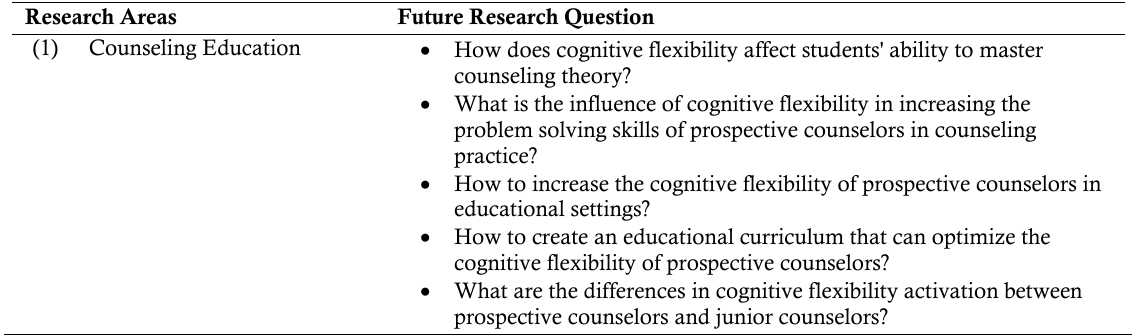
Table 2. Future Research